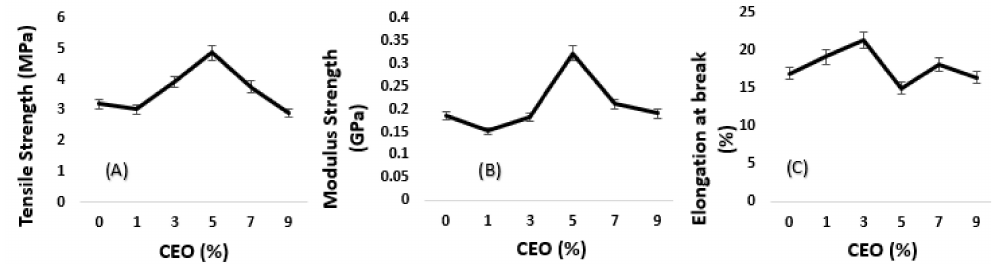
Figure 3. Effect of CEO on ( A ) tensile strength; ( B ) modulus strength; and ( C ) elongation at break of algae-based film.